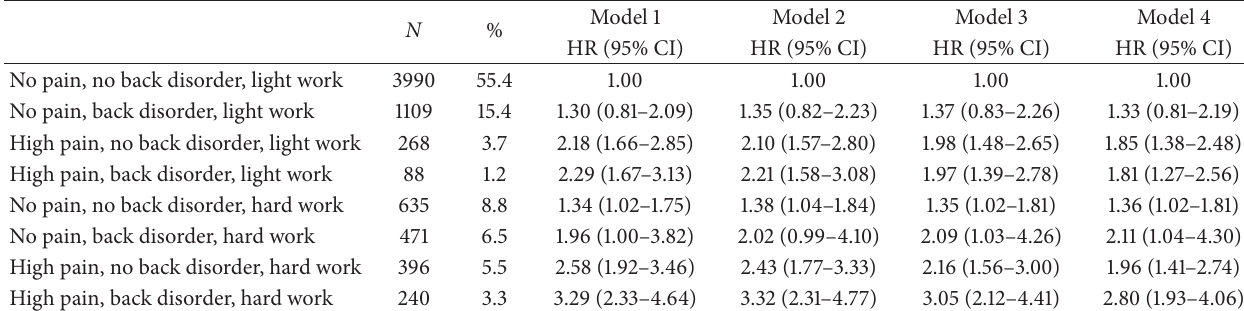
Table 4: The prospective associations between back pain intensity, physician-diagnosed back disorder, physical activity at work, and risk of LTSA. “No pain” refers to back pain intensity of 0–2 (0–9 scale) and “High pain” as back pain intensity of ≥ 5. N No pain, no back disorder, light